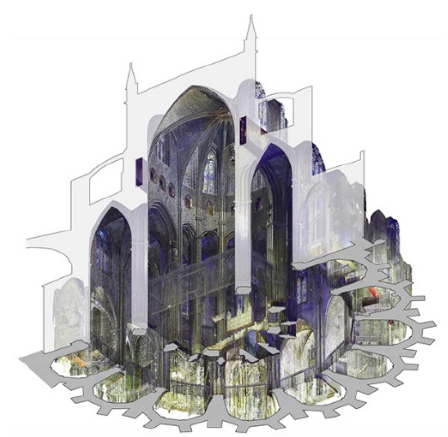
Figure 1: Apse of the Girona Cathedral. Image of the survey in a terrestrial laser scanner and type